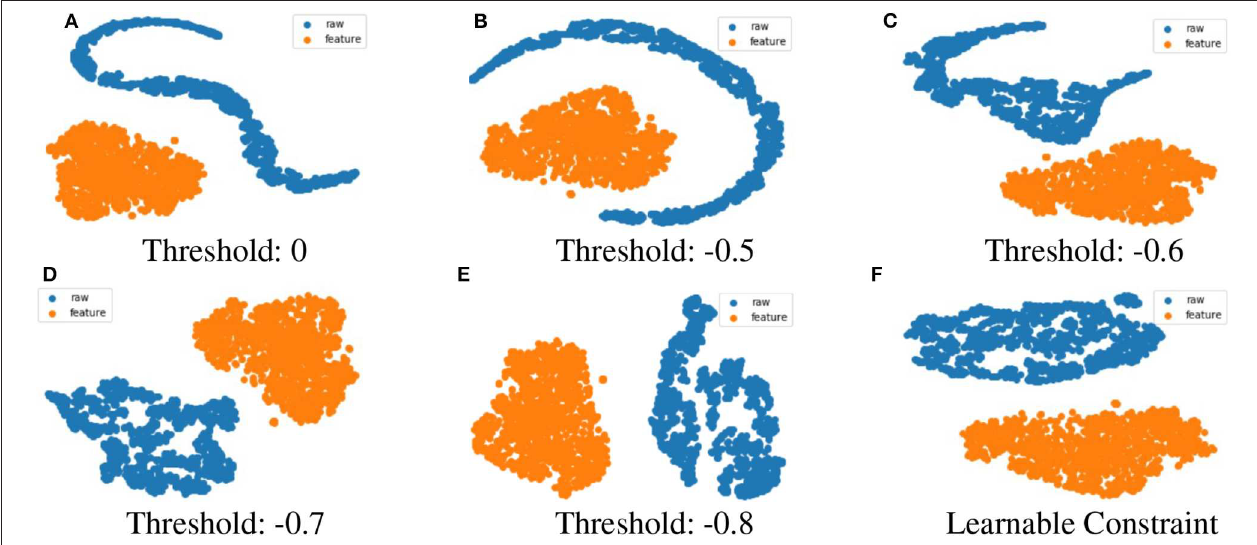
FIGURE 5 | The visualization of raw waveform complementary embedding and Feature Network embedding using eGeMAPS feature set in DCaEN are projected on two dimensional feature space. The visualization figure from (A–F) shows the increasing specified constraint values and the distribution patterns of two embeddings become similar while in a reverse